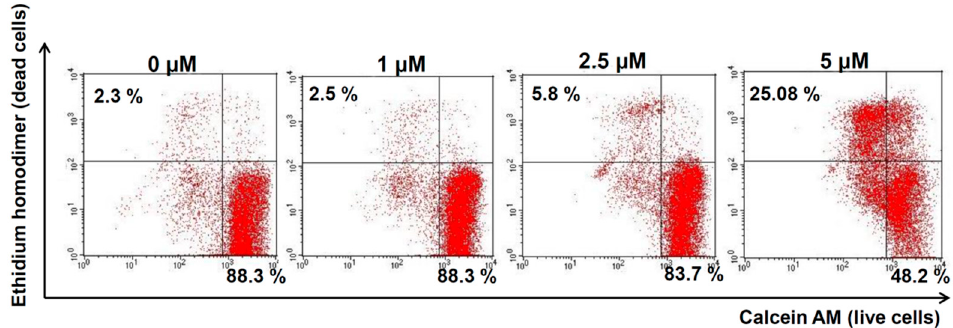
Figure 3. Compound 1 induced cell death in melanoma cells. 1205Lu cells were incubated with 1, 2.5, or 5 µM of compound 1 or DMSO (control) for 24 h and stained with ethidium homodimer and calcein AM. Live and dead cells were quantified by flow